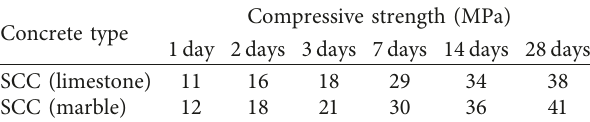
Table 8: Compressive strengths of four SCCs at different ages. Compressive strength Concrete type